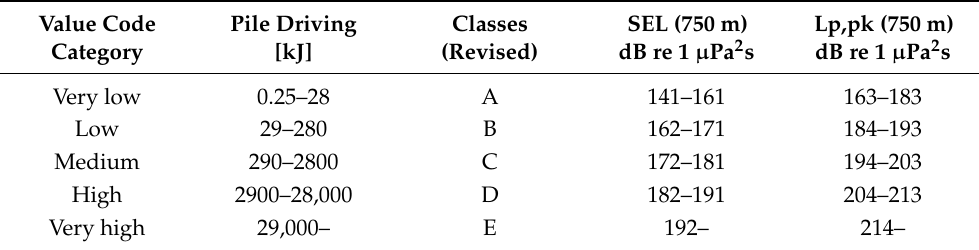
Table 3. Revised categorization of specific source levels for pile driving events into classes as proposed by TG Noise as adapted from [11], with permission from Müller et al.,